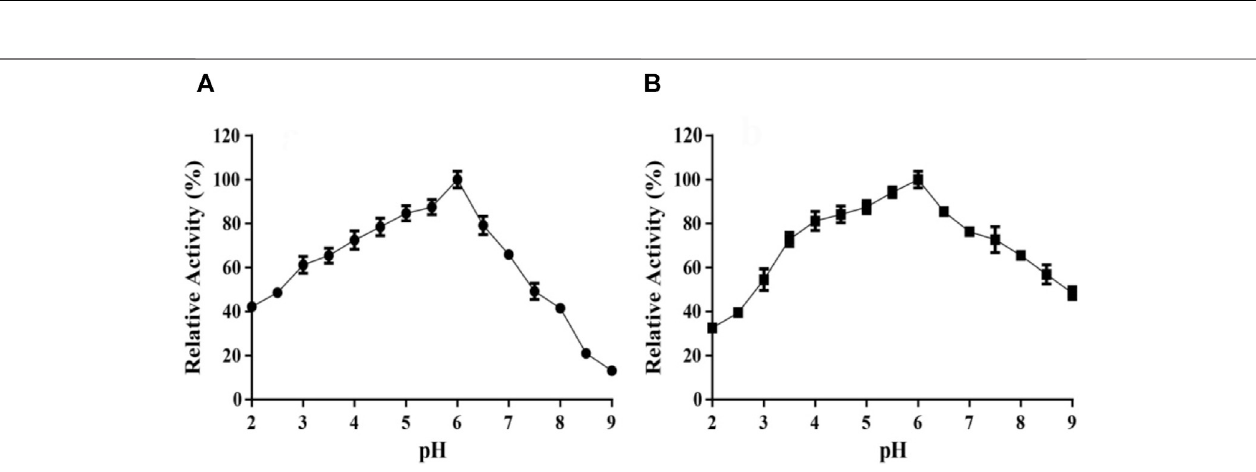
FIGURE 5 | Effects of pH on the activity (A) and stability (B) of TanA. (A) The optimal pH of TanA was investigated in the pH range of 2 – 11 with 100 mM buffers (glycine – NaOH, pH 8.5 – 11.0; Na 2 HPO 4 – citric acid, pH 2.0 – 8.0) by taking the activity at the optimum pH as 100%. (B) The pH stability of TanA was surveyed after incubationfor12 hat40 ° CinthepHrangeof2 – 11withthebuffersdescribedabove;thehighestresidualactivitywassetas100%.TheindifferentdatarangingfrompH9 to 11 were neglected and not shown in both fi gures (A) and (B)